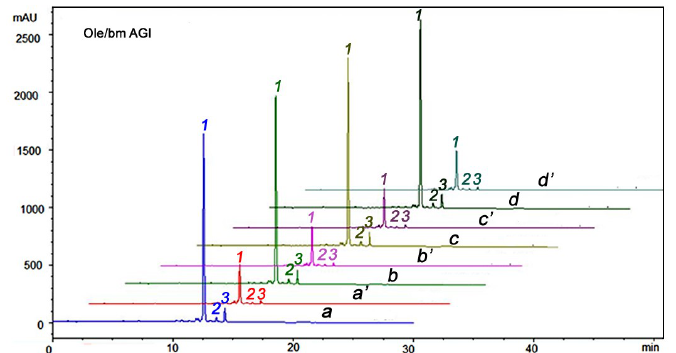
Figure 3. Olive BPseco HPLC/UV profiles; initial stage: a, λ = 240 nm and a′, λ = 280 nm; b and b′: pH = 4.2; t = 120 min; T = 25 °C; c and c′: pH = 1.5; t = 240 min; T = 37 °C; d and d′: pH = 6.0 and 8.0; t = 120 and 120 min; T = 37 °C, under experimental simulations of human digestive and olive processing conditions. Peak 1: oleuropein; peak 2: isomer unidentified; peak 3: oleuroside.